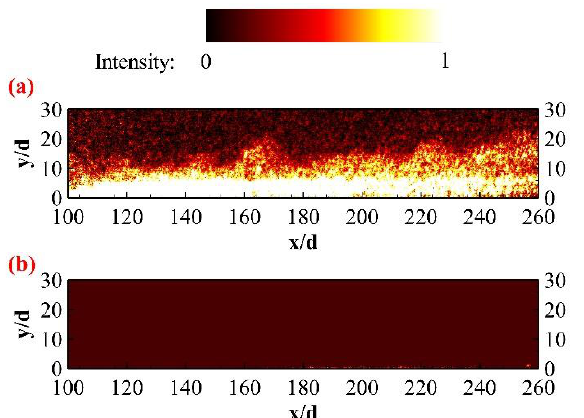
Figure 3. Comparison of fluorescence signal ( a ) with acetone, ( b ) without acetone (Test 1-1, operating condition).